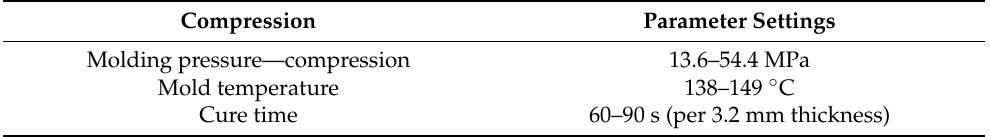
Figure 2. Experimental production equipment. ( a ) Hydraulic press. ( b ) Compression mold. Table 2. Suppliers suggested start-up